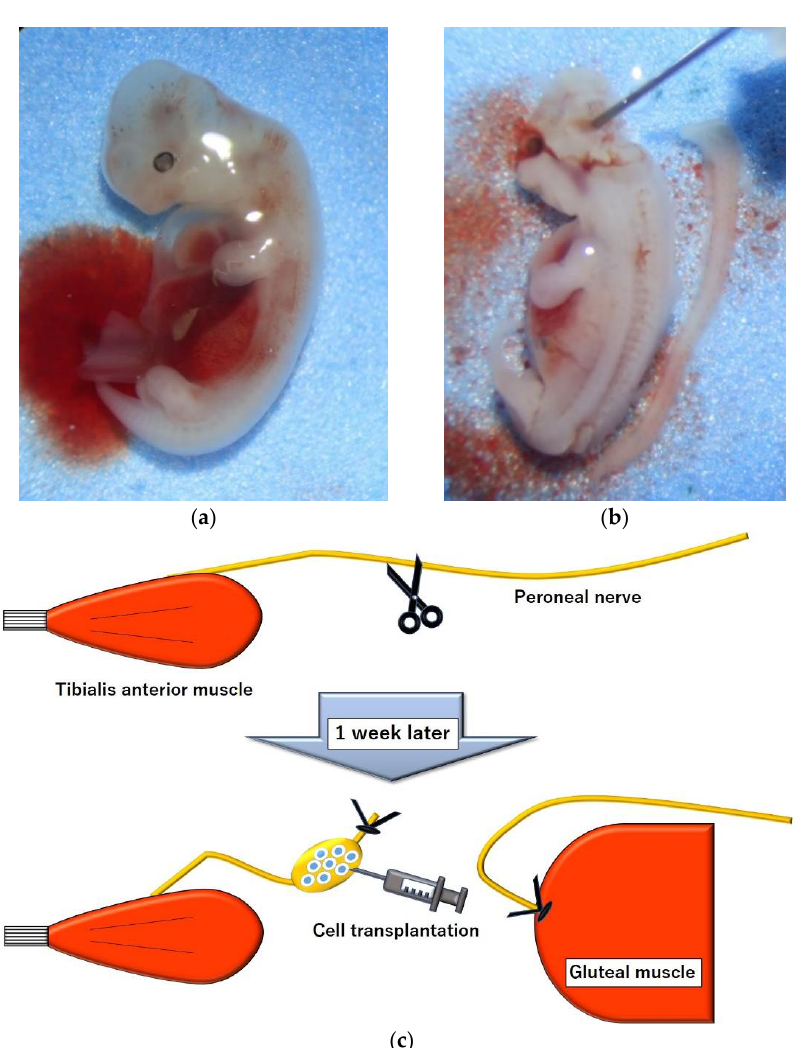
Figure 8. Model and cell preparations. ( a ) The 27-day-old pig embryo; ( b ) image showing harvested spinal cord from the embryo. ( c ) Diagram showing the surgical procedure for preparing the peroneal nerve of rats and injecting the medium containing neural cells into the distal stump of the peroneal nerve.